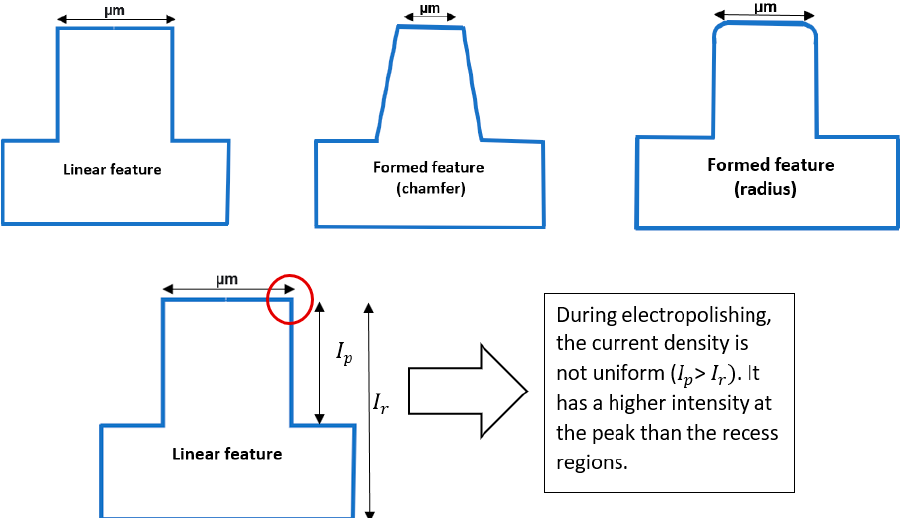
Figure 27. Electropolishing for shaping of micro-scale features.